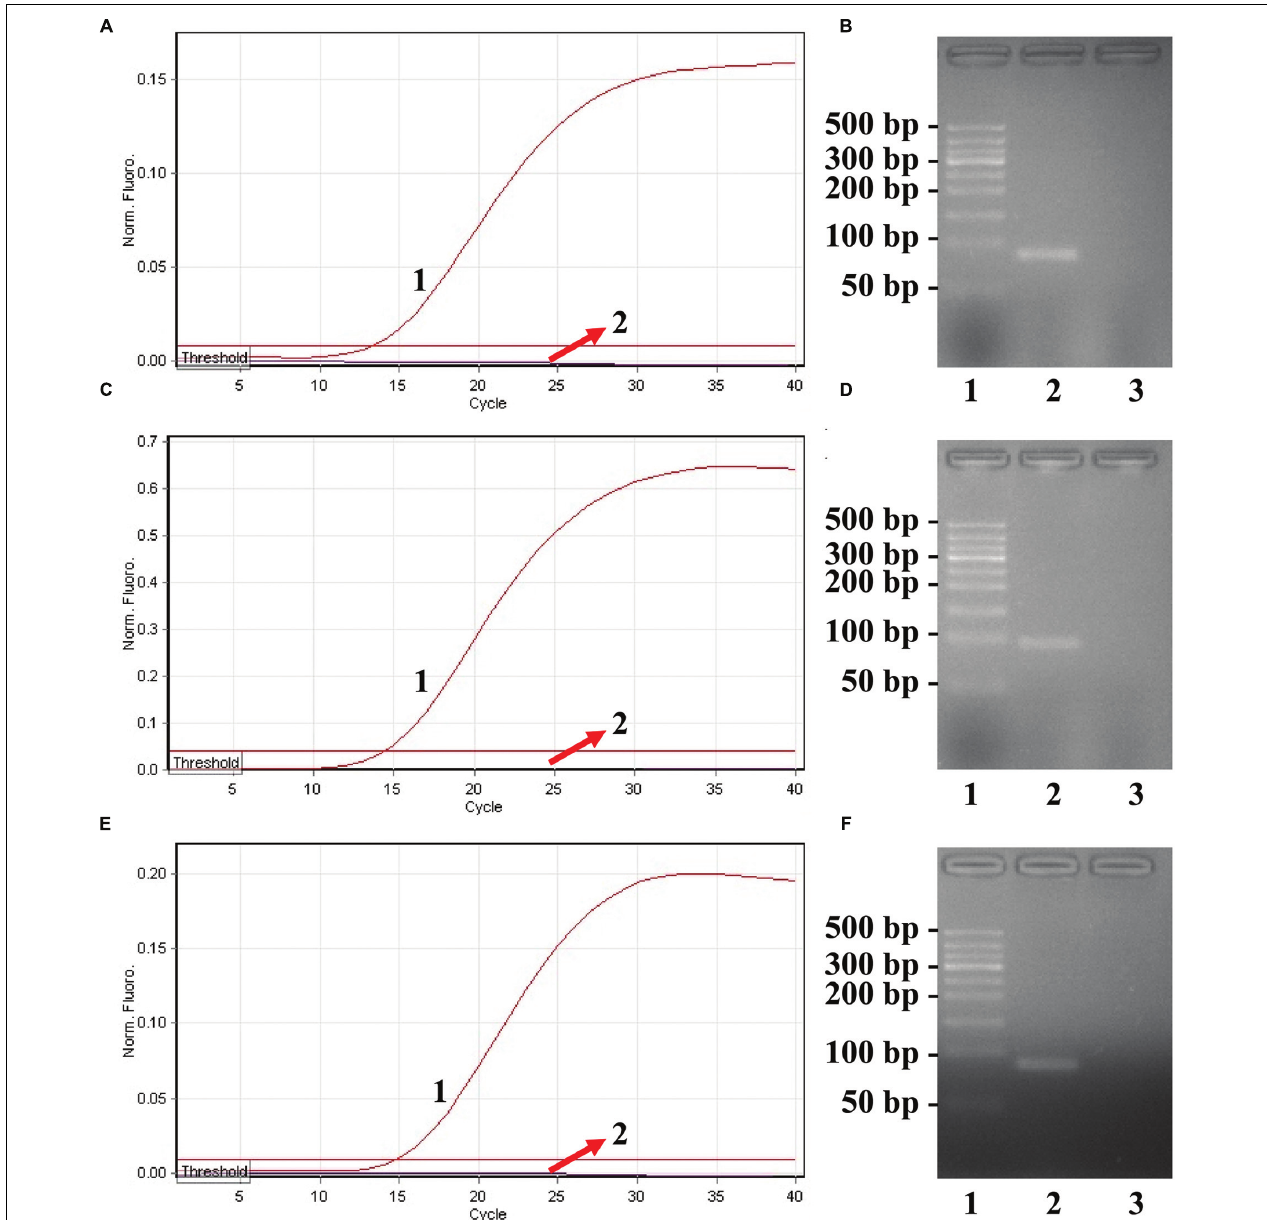
FIGURE 3 | Confirmation and detection of ET-PCR products. (A) , (C) , and (E) , the ET-PCR was detected by means of real-time format, and the three figures were obtained from HEX (labeling S. p-EF of ply ), Cy5 (labeling S. a-EF of nuc ), and FAM (labeling E. f-EF of Ef0027 ) channels. Signals A1, C1, and E1 indicate Streptococcus pneumoniae , Staphylococcus aureus, and Enterococcus faecalis strains in HEX, Cy5, and FAM channels, respectively, and signals A2, C2, and E2 for negative control. (B) , (D) , and (F) , agarose gel electrophoresis applied to ET-PCR products; lane 1, DL 50-bp DNA markers, lane 2, positive ET-PCR products; lane 3, negative control (no